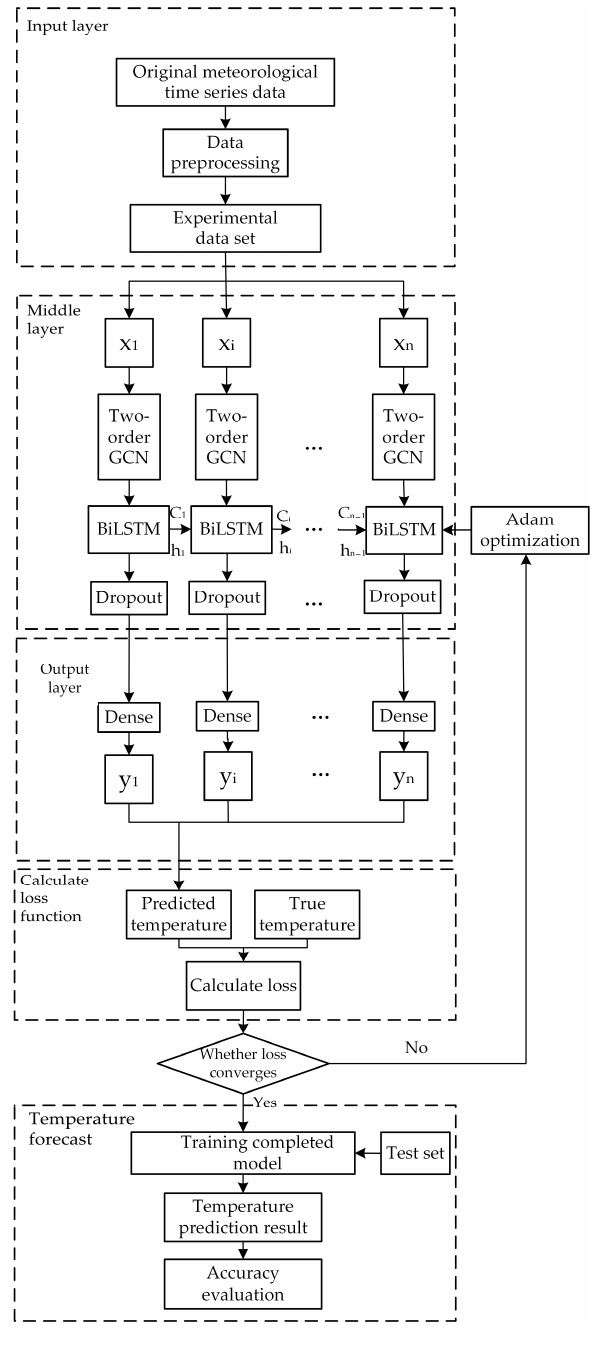
Figure 6. The workflow of the GCN-BiLSTM model.